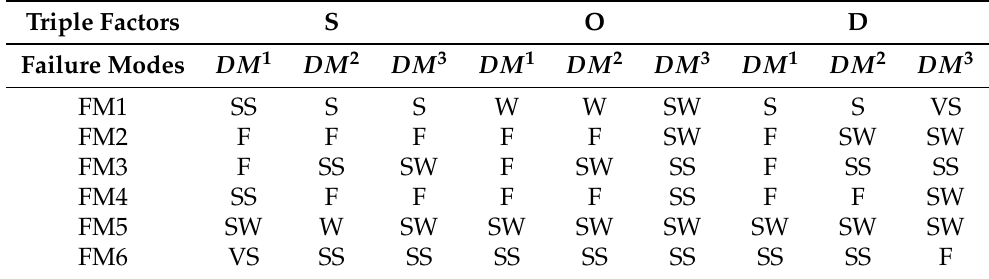
Table 8. Assessments of failure modes concerning risk factors evaluated by the DM